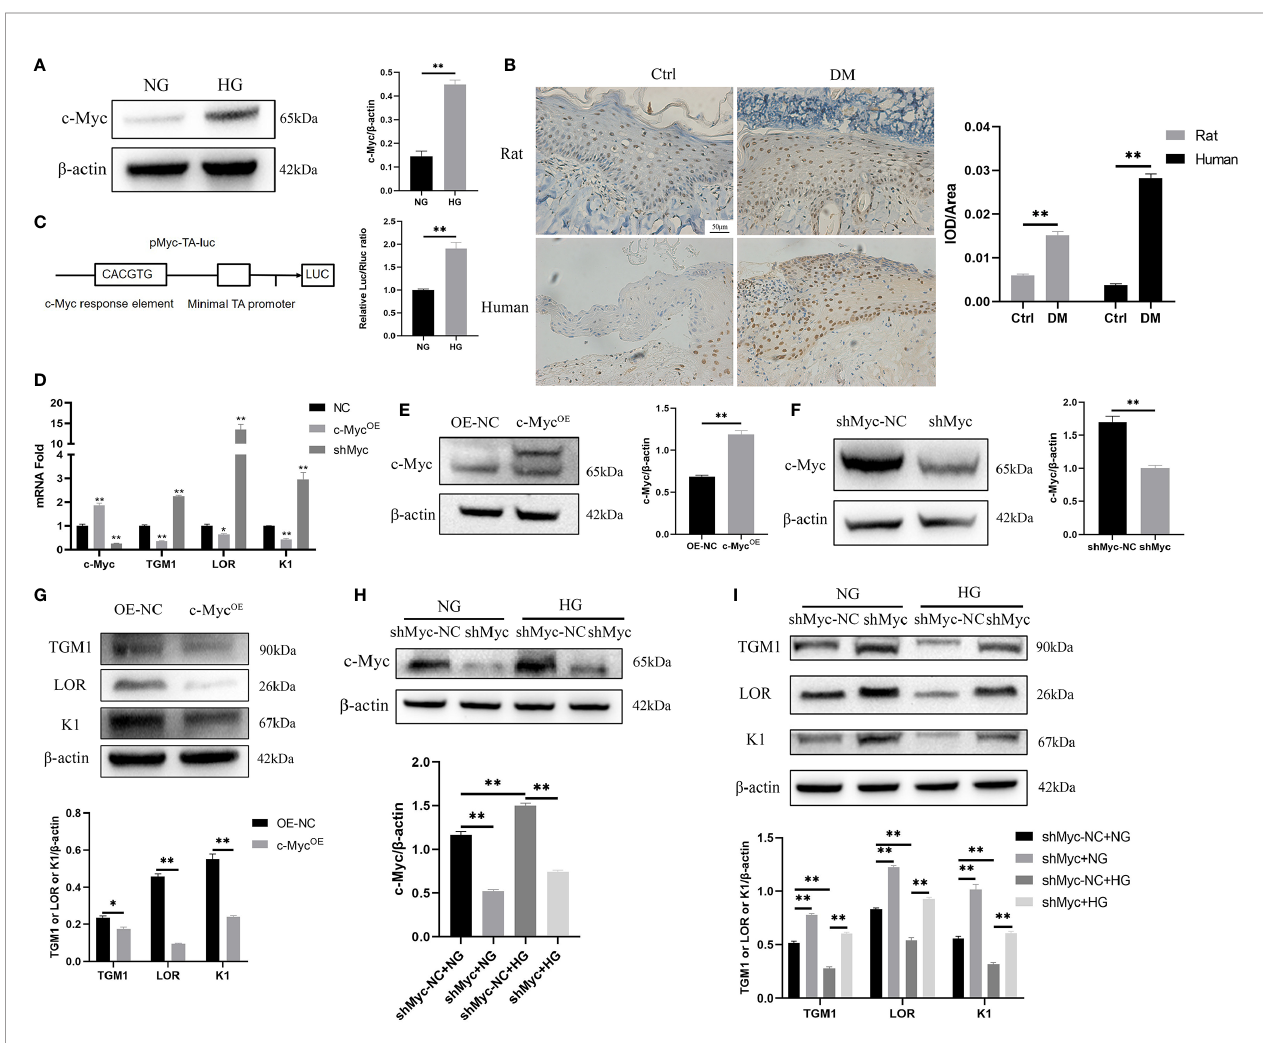
FIGURE 2 | High glucose inhibits differentiation by increasing the expression and transcription activity of c-Myc (A, B) c-Myc expression was analyzed by western blot (A) and immunochemistry (B) . Magni fi cation: ×200, Scale bar = 50 m l. (C) Schematic illustration of the c-Myc transactivation assay. 293T cells were cultured with high glucose or normal glucose for 5 days and then transfected with 500 ng pMyc-TA-luc and 50 ng Renilla. Fire fl y and Renilla luciferase activities were measured 36 h after transfection. (D) mRNA levels of c-Myc , TGM1, LOR, and K1 in HaCaT cells with c-Myc overexpression or knockdown were analyzed by PCR. (E, F) c-Myc protein level after c-Myc overexpression (E) or knockdown (F) was analyzed by western blot. (G) Protein levels of TGM1, LOR, and K1 in HaCaT cells with c-Myc overexpression were analyzed by western blot. (H, I) Protein levels of c-Myc (H) , TGM1, LOR, and K1 (I) in HaCaT cells with c-Myc knockdown in the NG or HG condition were analyzed by western blot. OE-NC, the negative control of c-Myc overexpression. shMyc-NC, the negative control of c-Myc knockdown. Data were shown as the mean ± SEM measured in triplicate from three independent experiments. ANOVA followed by Tukey ’ s multiple comparisons test were performed to analyze the differences. *P < 0.05, ** P <